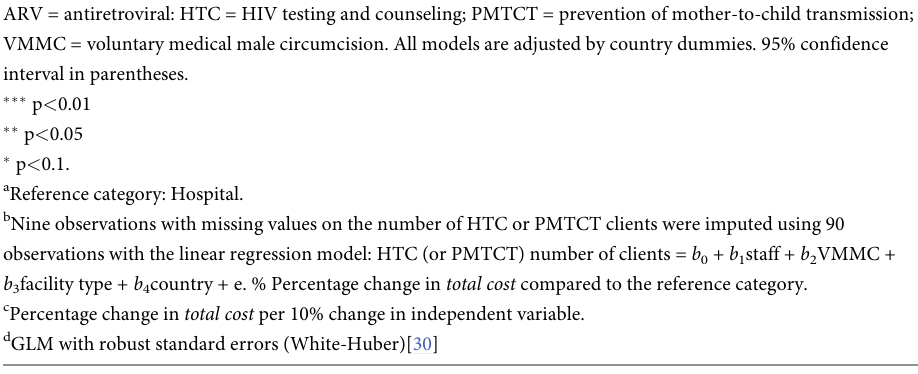
100 100 100 ARV = antiretroviral: HTC = HIV testing and counseling; PMTCT = prevention of mother-to-child